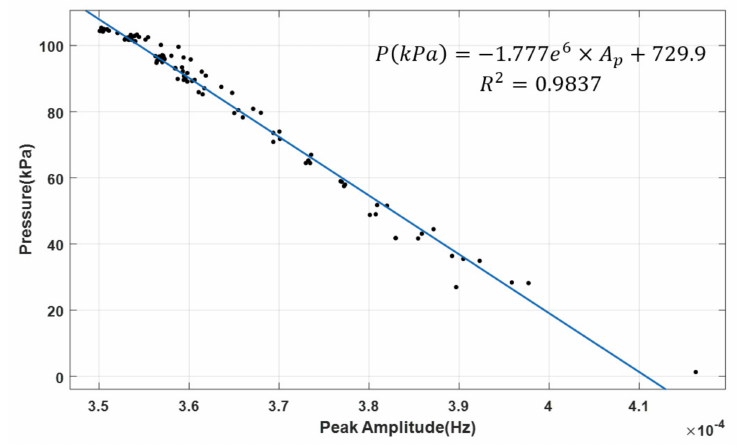
Figure 11. Results of linear regression between pressure and amplitude of EMI.